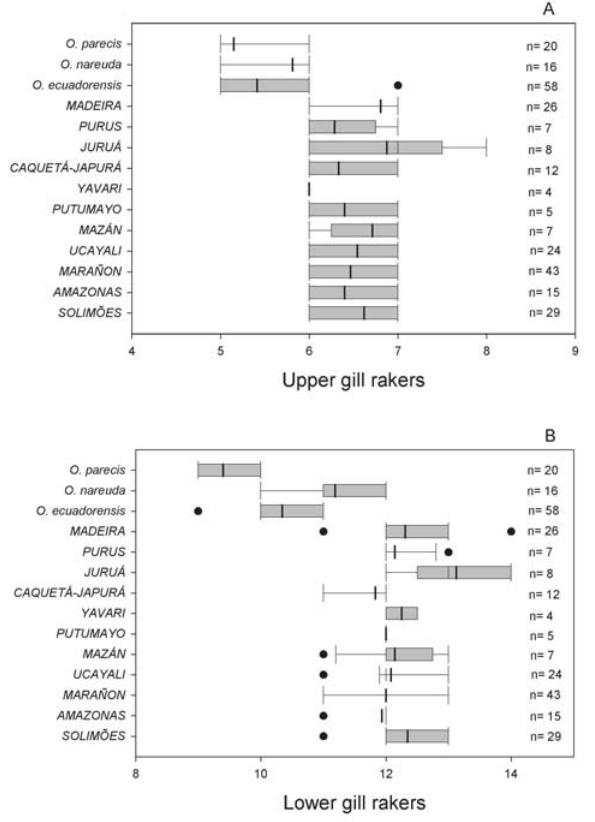
Fig. 13. Upper and lower gill rakers counts of Odontostilbe fugitiva populations, and three new species Odontostilbe ecuadorensis , Odontostilbe nareuda , and Odontostilbe parecis